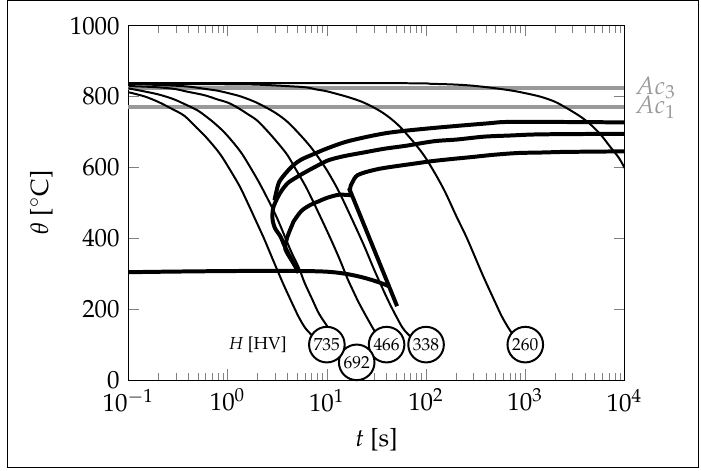
Figure 1. CCT diagram of a 0.55% carbon steel austenitized at 840 ◦ C